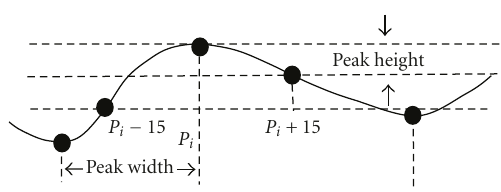
Figure 2: Invariance of DYWT to jittering.